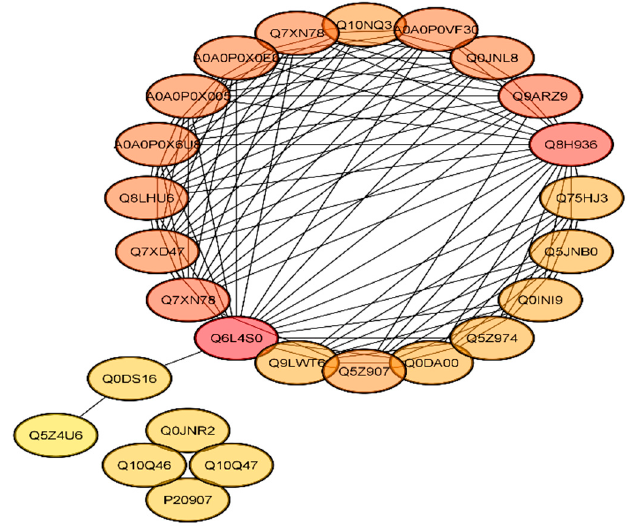
Figure 6. Protein–protein interaction (PPI) network of differentially expressed proteins (DEPs). The nodes with redder color showed a higher degree of interaction, whereas the nodes out of the circle showed less or no interaction.